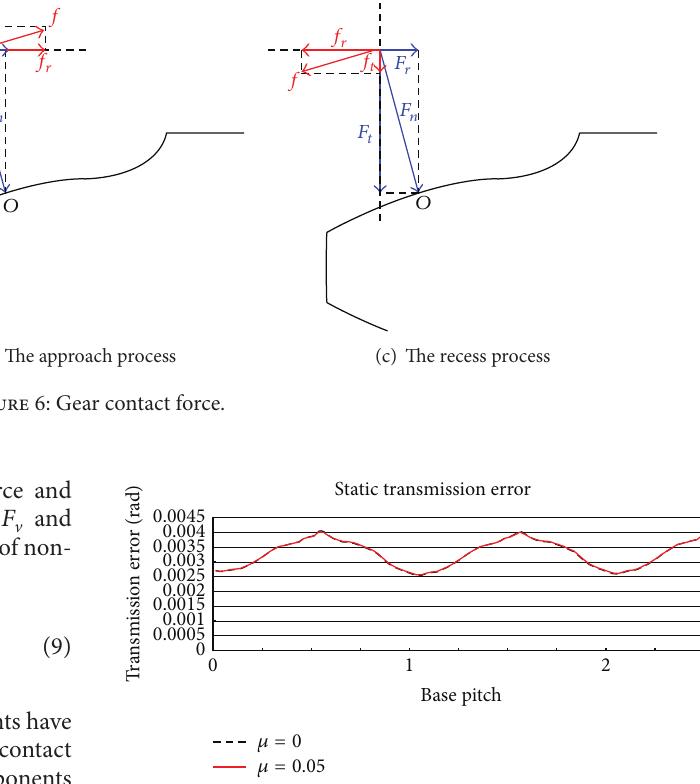
Figure 7: Static transmission error